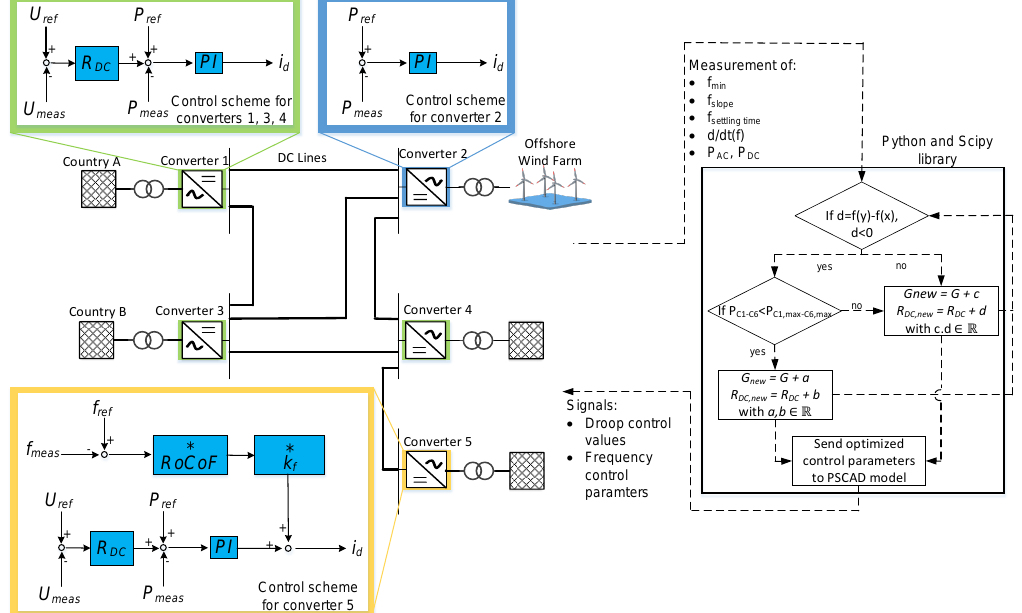
Figure 4. Methodology for the optimization of the AC grid stabilization using a PSCAD and Python interface.